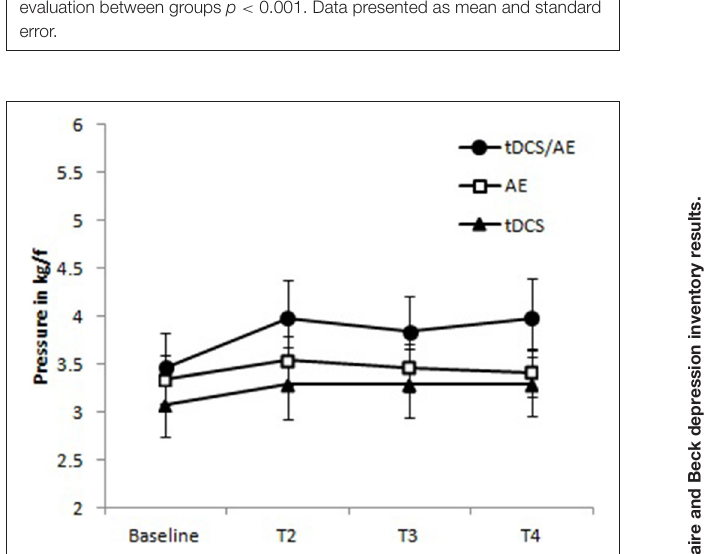
FIGURE 6 | Data for pressure pain threshold. Group tDCS/AE demonstrating a relative of the pressure pain threshold increased, maintained during periods of follow-up. Group AE slight increase after the intervention, apparently not maintained at follow-up period. tDCS group with mild increase in the pressure pain threshold, being held in the follow-up period. No statistical significant data were observed. Data shown as mean and standard